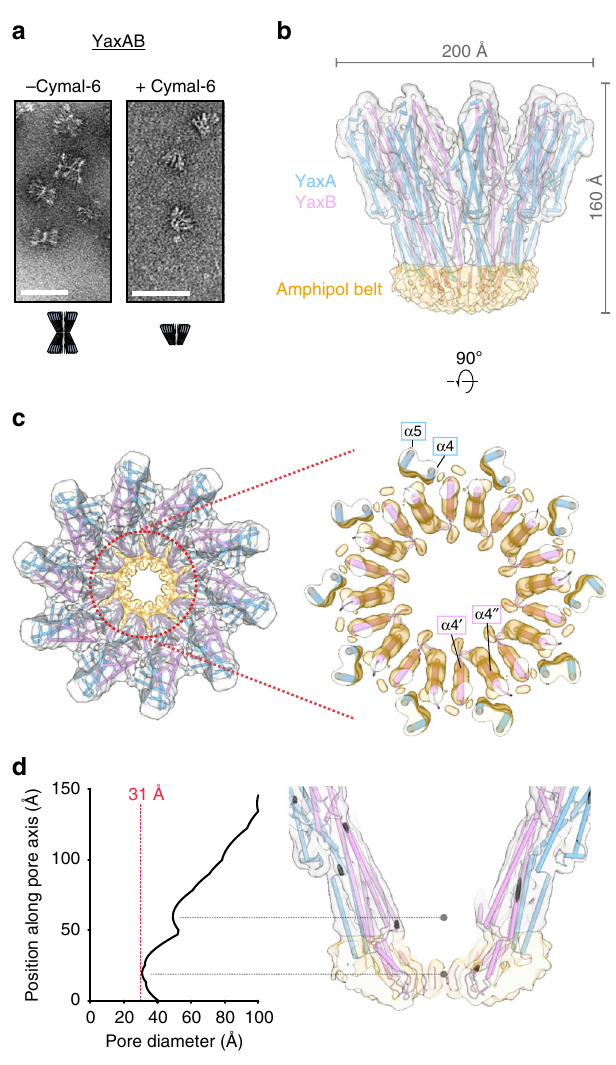
Fig. 2 Cryo-EM structure of the YaxAB complex reveals an α -helical transmembrane pore. a Negative-stain TEM micrographs of YaxAB complexes in solution. Left: sample in absence of detergent. Right: sample in presence of 0.1% Cymal-6. Scale bar = 50 nm. b Final sharpened cryo- EM density of YaxAB together with the fi tted pore model, shown from side view. The chosen contour level (4.5 σ ) corresponds to the 1.21 Å 3 /Dalton convention according to Harpaz et al. 65 . Fitted YaxA and YaxB models are colored blue and pink, respectively. The amphipol belt, illustrated in gold, is clearly visible and demarcates the putative transmembrane region. c Top view of the pore complex, overlaid with the fi nal cryo-EM map. YaxA and YaxB form outer and inner rings, respectively (left). A zoom of the amphipol-enclosed portion of the complex (right) is contoured at 6.5 σ to better distinguish individual helices. Labels of the secondary structure elements adhere to the nomenclature shown in Fig. 1b. d Pore diameter plotted against the coordinate along the vertical axis. Calculations have been performed using the program HOLE 66 (left). The red line indicates the narrowest point in the channel. Two major constrictions along the YaxAB model are emphasized